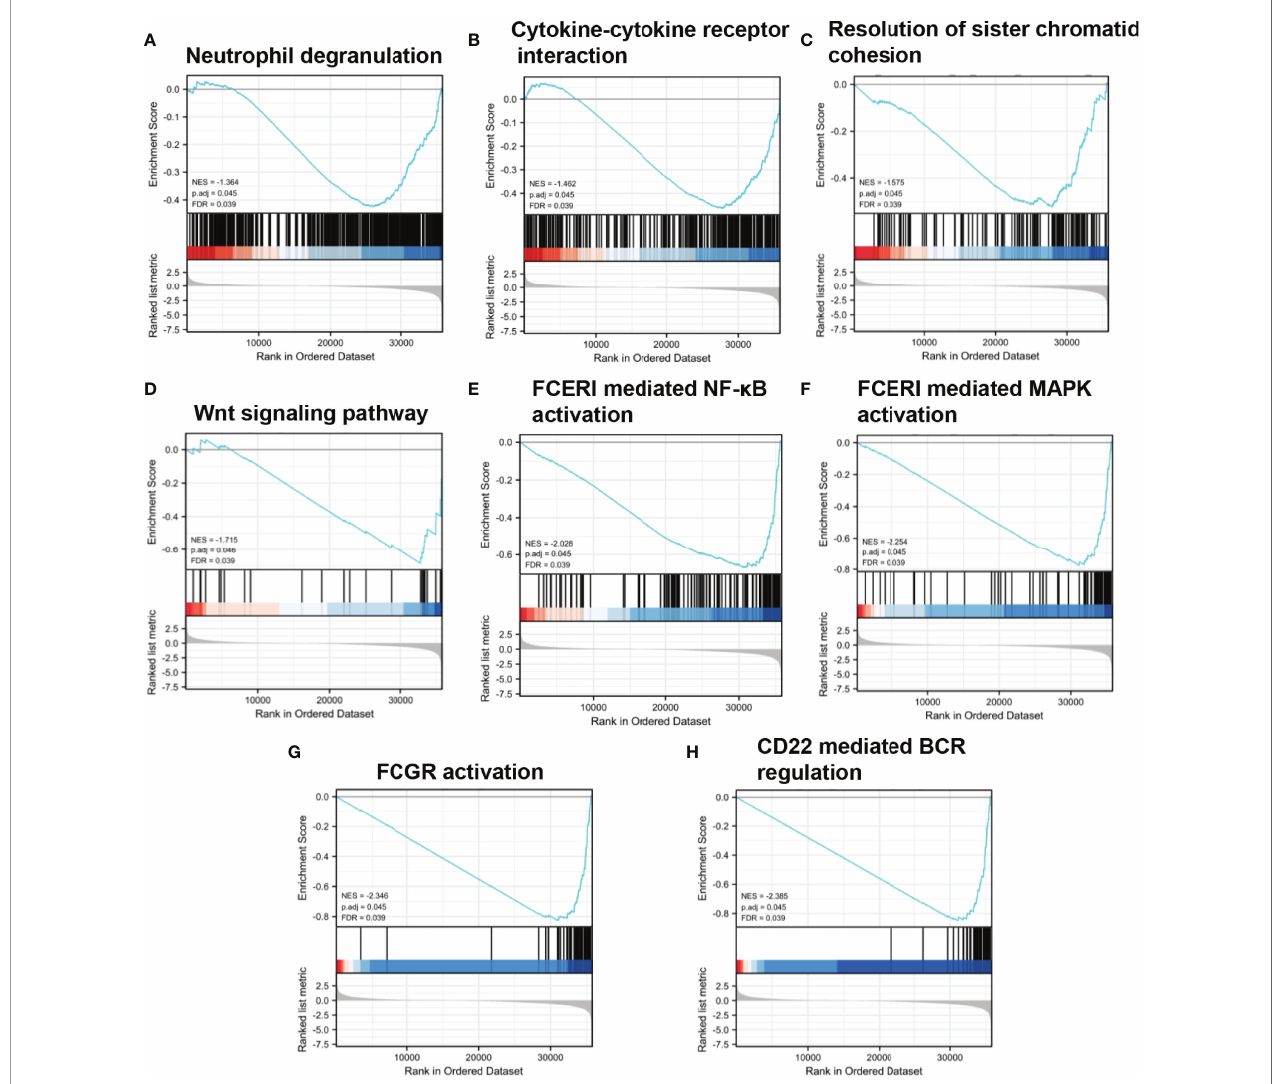
FIGURE 5 | Enrichment plots from GSEA. (A – H) NES, normalized ES; ADJ P-val, adjusted P-value; FDR, false discovery